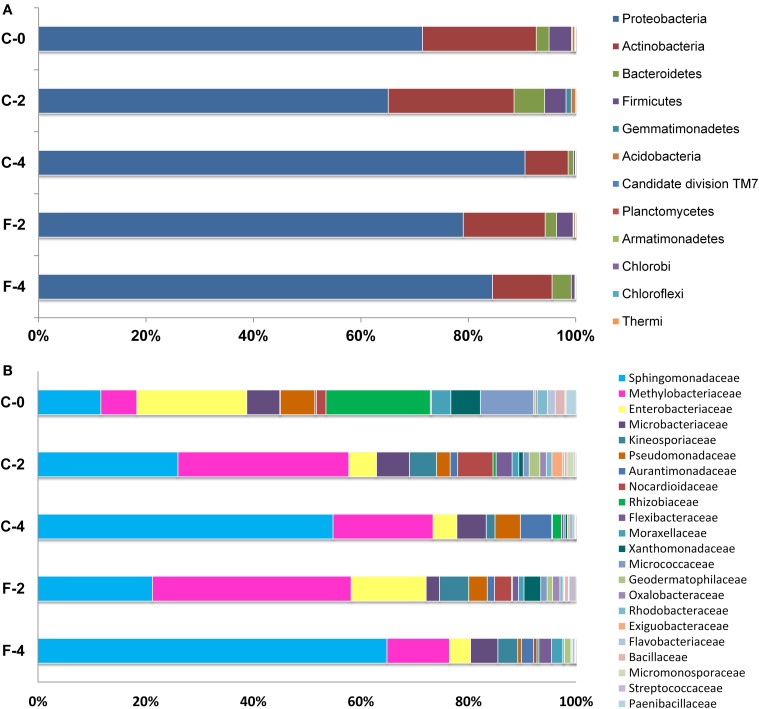
Relative abundance of bacterial phyla (A) and families (B, taxa represented occurred at >1% abundance in at least one sample) associated with Stevia leaves as determined from pyrosequencing. Percentages represent the portion of 16S rRNA gene 454 reads which were classified to that phylum and family.